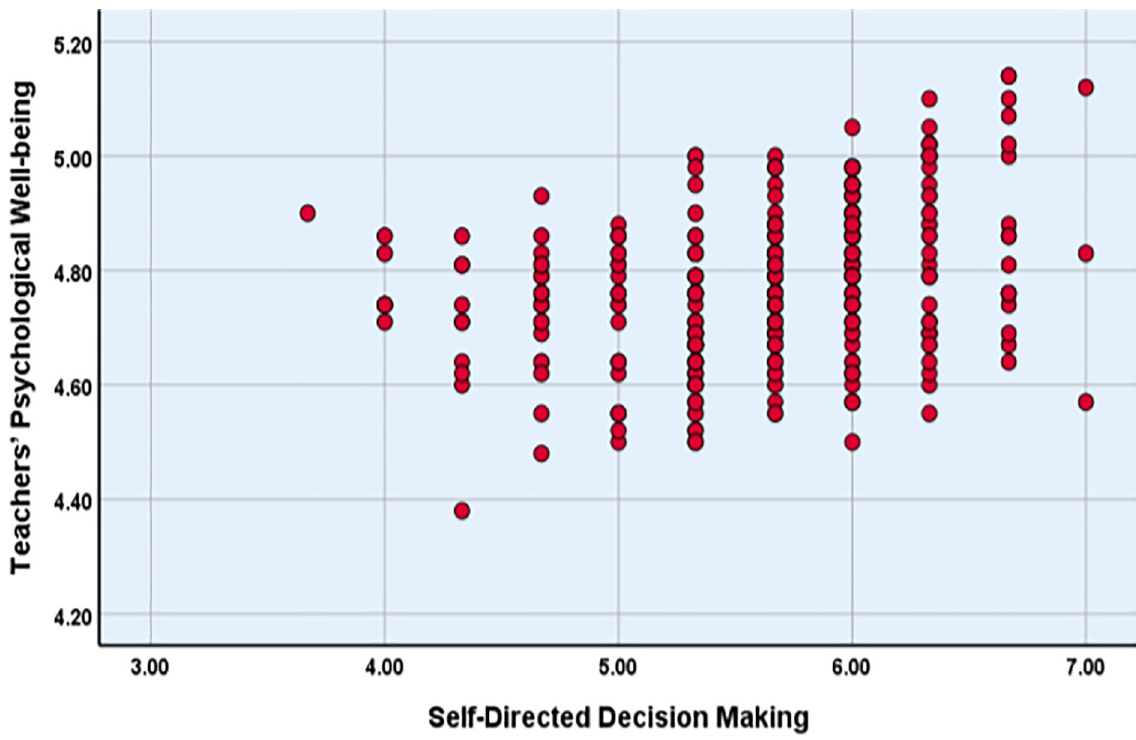
Fig 5. Pearson’s product-moment correlation between self-directed decision making and teachers’ psychological well-being. The scatterplot plainly depicts the significant positive relationship between self-directed decision making (subdomain of leadership empowering behaviour) and teachers’ psychological well-being at secondary